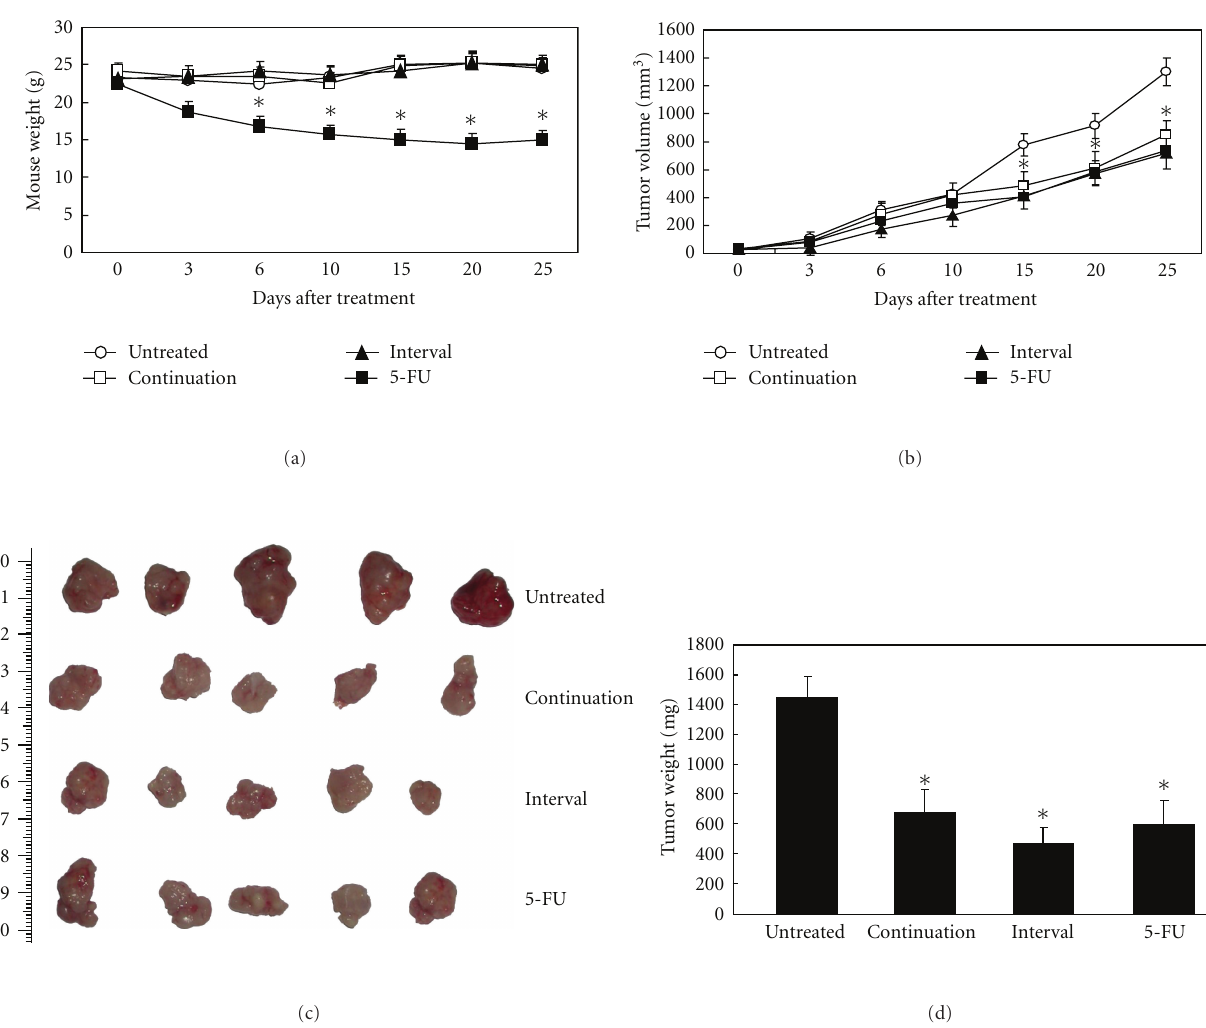
Figure 3: Antitumor e ff ects of CIK cells in vivo . Nude mice ( n = 30) were injected subcutaneously with 5 × 10 6 SW1116 colorectal cancer cells. In the CIK-consecutive-treated group, 5 × 10 8 CIK cells were injected abdominally into the mice once every day for 5 days. In the CIK-interval-treated group, 5 × 10 8 CIK cells were injected abdominally into the mice once every 5 days on 5 occasions, namely 5 times in 3 weeks. In the 5-FU-treated group, 5-FU was injected intravenously at 50mg/kg. Body weights were measured every 2 days (a). Tumor volumes were calculated by using the formula: length (mm) × width (mm) × height (mm) (b). Representative photographs are shown (c). On day 30, the mice were sacrificed, and the tumor weights were determined (d). Standard deviations and P -values were calculated with Student’s t -test ( P < .